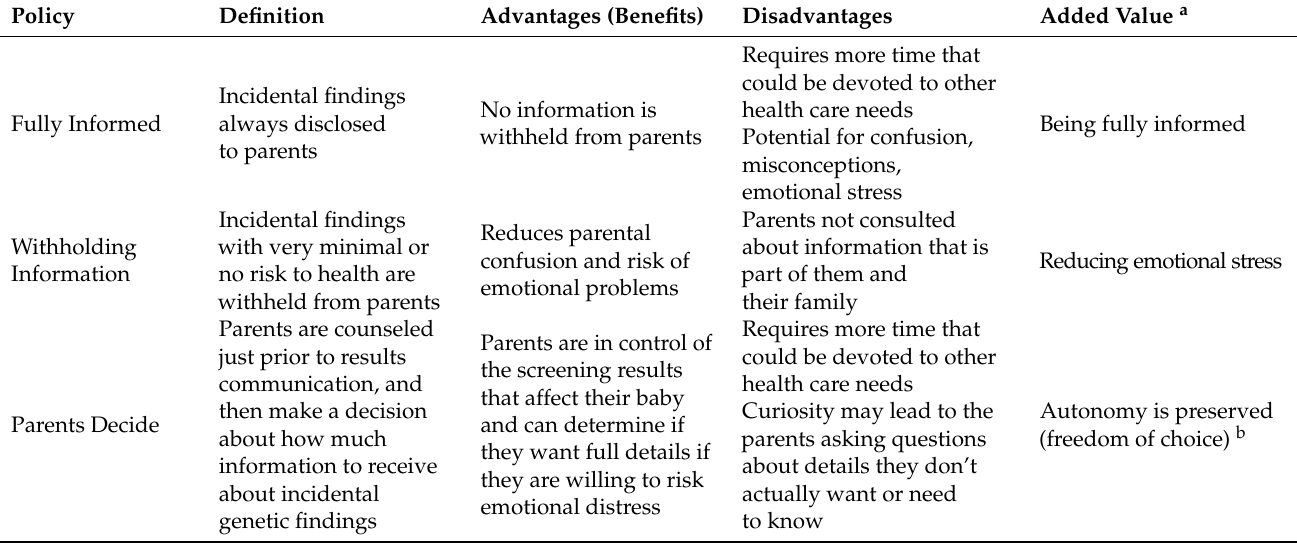
Table 1. Disclosure Policy Definitions and Associated Advantages, Disadvantages, and Added